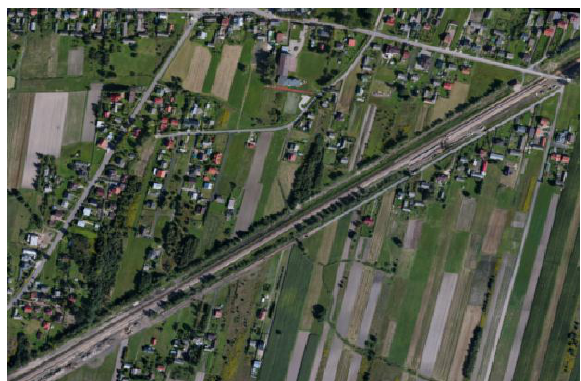
Figure 2. Orthophotomosaic- fragment of the test